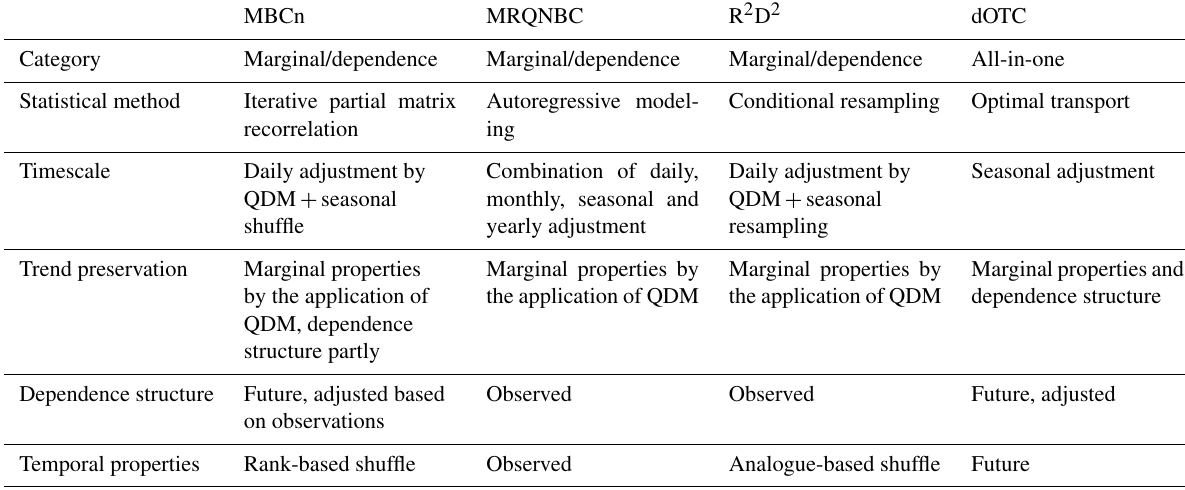
Table 2. Overview of the multivariate bias-adjusting